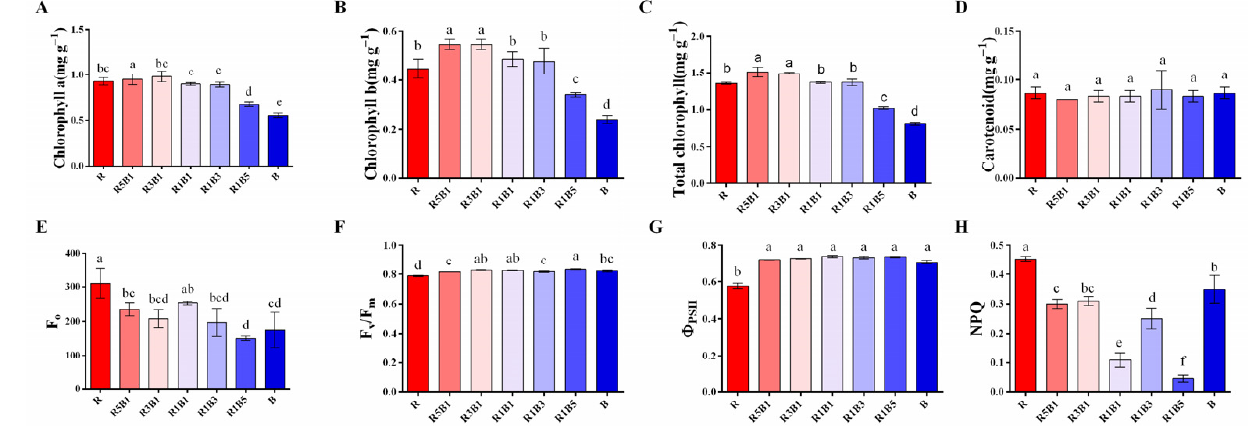
Figure 4. ( A – D ) represents the content of chlorophyll a ( A ), chlorophyll b ( B ), total chlorophyll ( C ), and carotenoid ( D ), respectively, under seven different spectral treatments. Bars represent the mean ± SD ( n = 3). ( E – H ) represents the content of F o : Initial fluorescence ( E ), F V /F m : PSII primary light energy conversion efficiency ( F ), Φ PSII : actual photochemical efficiency of PSII ( G ), and NPQ: non − photochemical quenching ( H ) under seven different spectral treatments. Bars represent the mean ± SD ( n = 6). According to one way ANOVA, different letters denote statistically significant differences be-tween treatments (Duncan’s test, p < 0.05). R: monochromatic red light; R1B5: red to blue ratio = 1:5; R1B3: red to blue ratio = 1:3; R1B1: red to blue ratio = 1:1; R1B3: red to blue ratio = 1:3; R1B5: red to blue ratio = 1:5; B: monochromatic blue light.